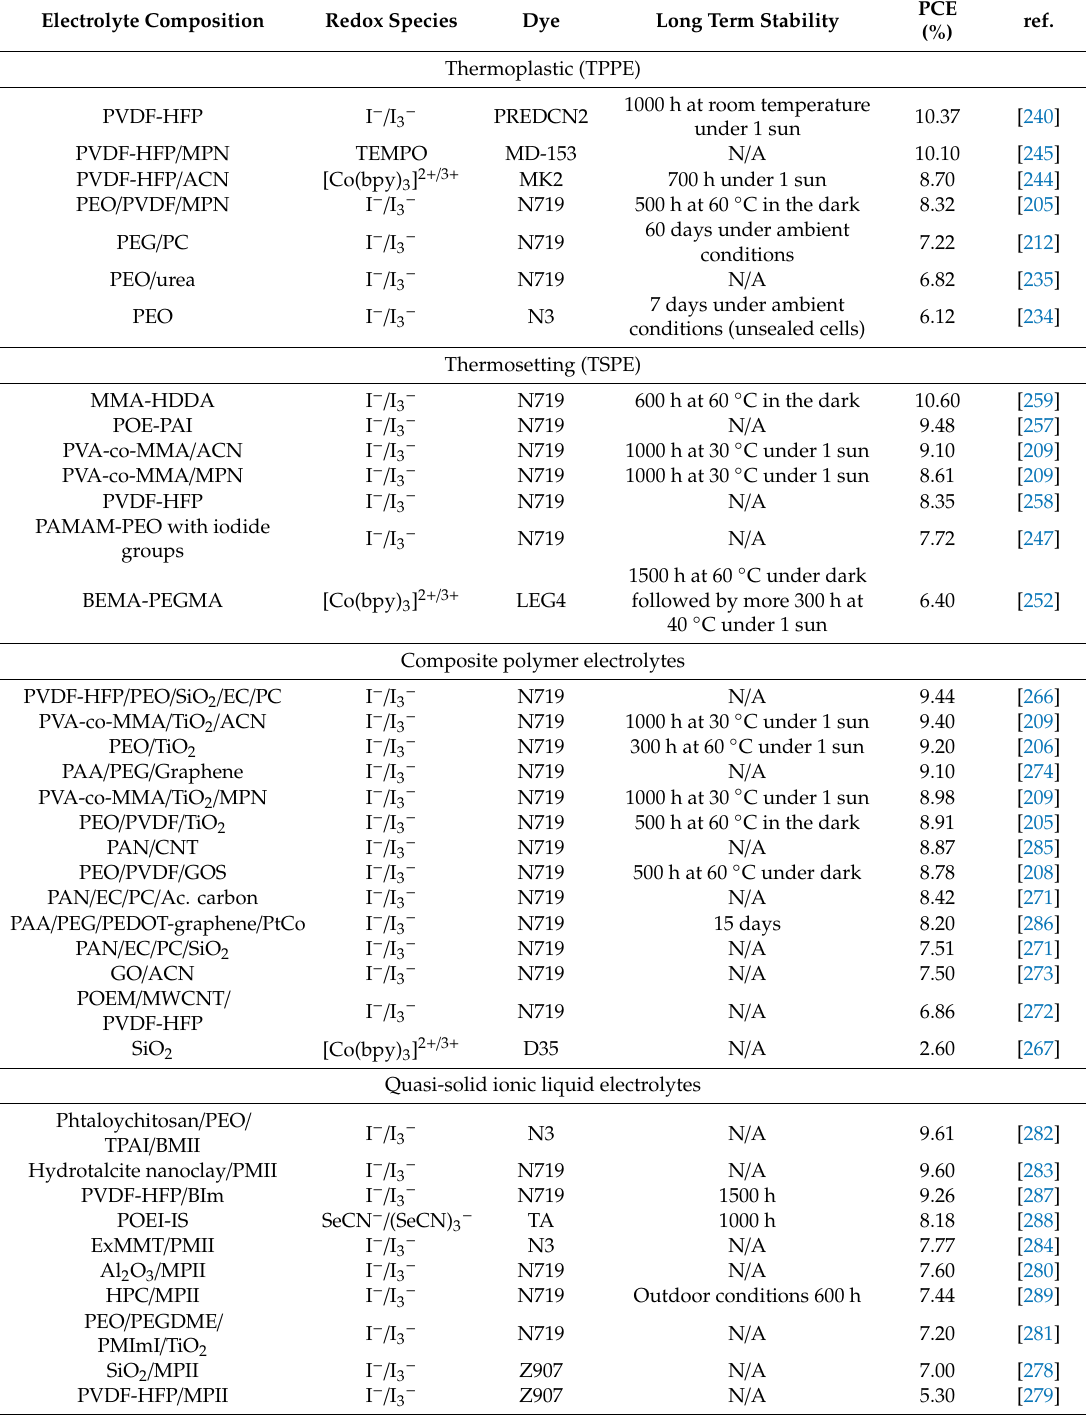
Table 7. Best e ffi ciencies reported with gel